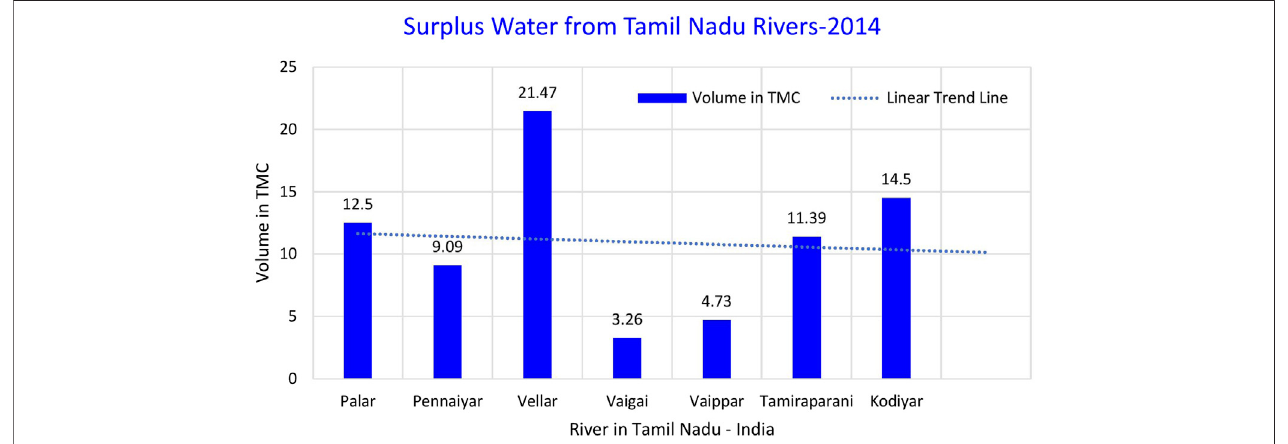
FIGURE 6 | Surplus water from Tamil Nadu river basin. Source: The Hindu (June 23, 2014).